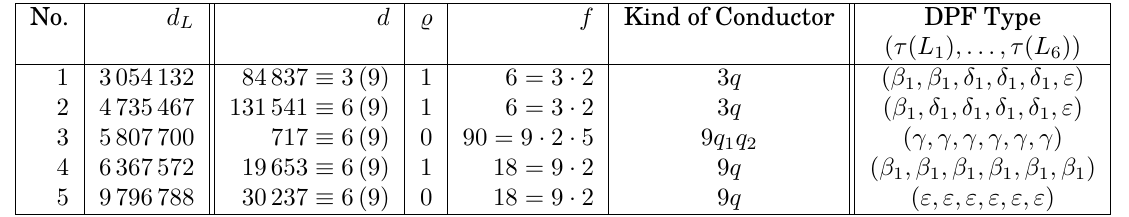
Table 18: Five explicit sextets in the range 0 < d L < 10 7